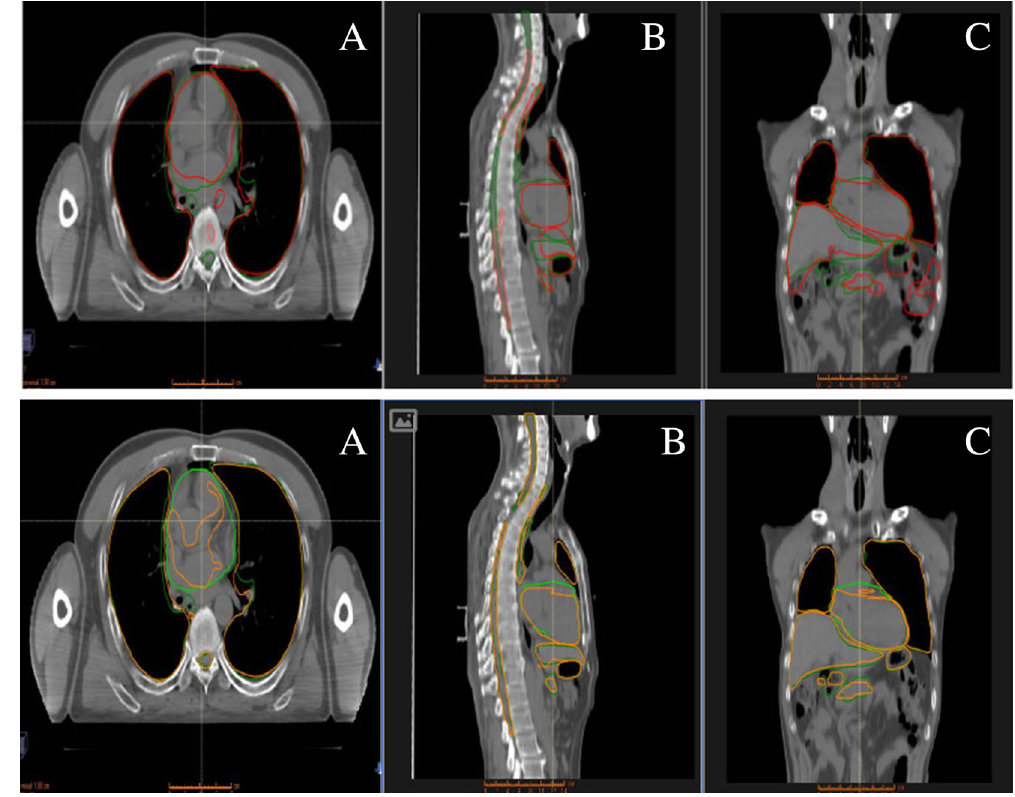
Figure 2. Comparison of OAR results of lung cancer patients using two software. [( A ) is the traverse plane, ( B ) is the sagittal plane, ( C ) is the coronal plane].